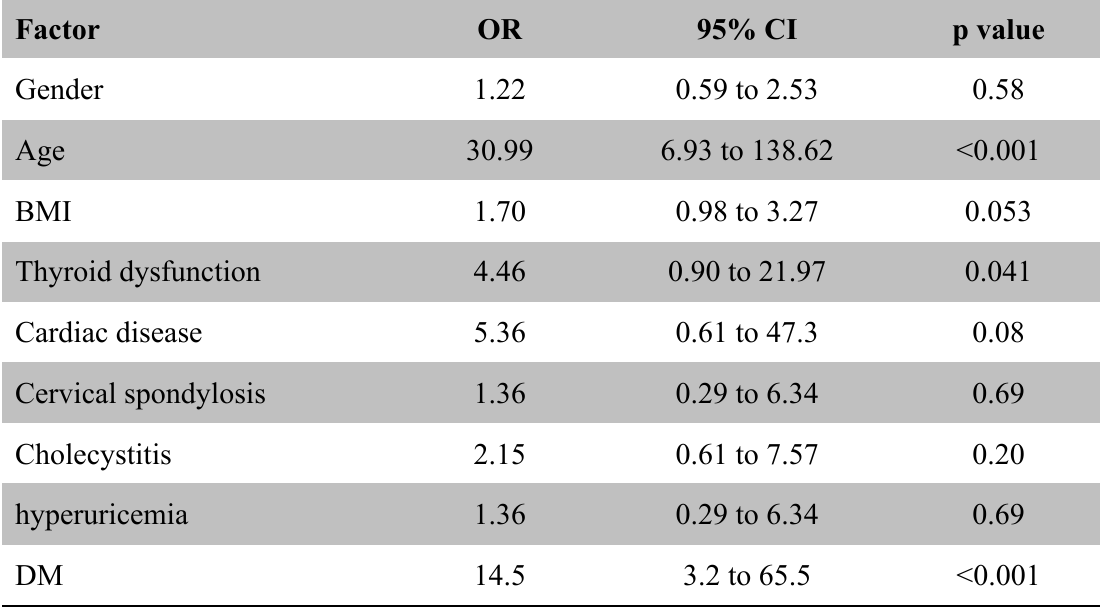
Table 2: Univariate logistic regression analysis of the potential risk factors associated with a frozen shoulder between case and control groups.